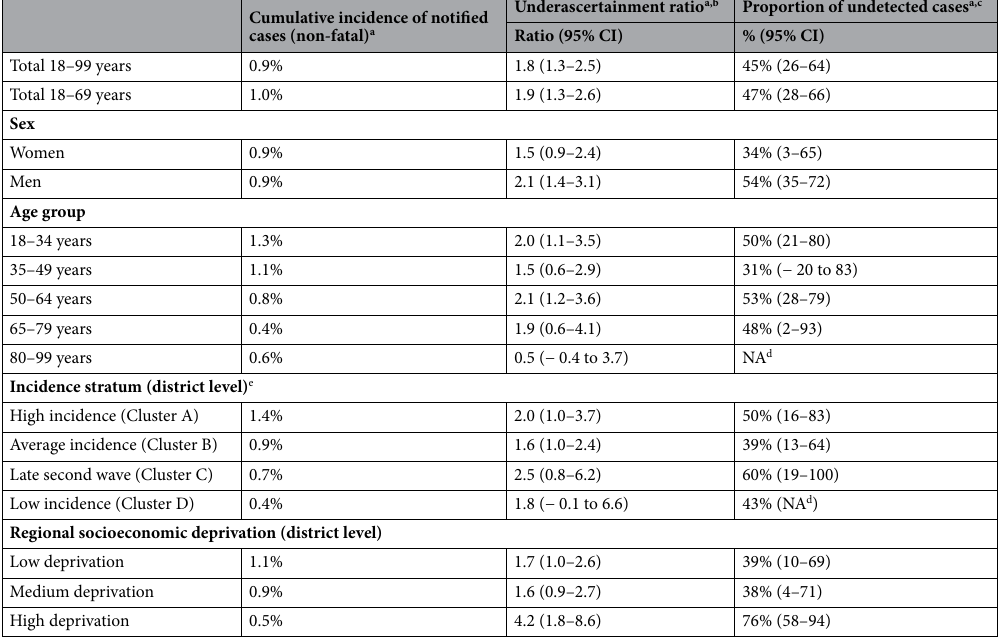
Table 3. Cumulative incidence of notified cases, underascertainment ratio and estimated proportion of undetected cases. a Cumulative incidence of notified cases in Germany, adjusted for sampling-density (i.e. each participant contributes according to the sex-, age group- and district-specific cumulative incidence of notified cases with symptom onset (notified or imputed) corresponding to his/her DBS testing date minus 14 days). b Underascertainment ratio: Ratio of seroprevalence to cumulative incidence of notified cases. Seroprevalence population-weighted IgG seroprevalence corrected for specificity = 0.997 and sensitivity = 0.616 that includes antibody decay observed in the study. c Proportion of undetected cases: seroprevalence minus cumulative incidence of notified cases, divided by seroprevalence. d NA = estimate not available. e District incidence strata according to pattern of weekly sequence of district SARS-CoV-2 incidence (notified cases), see Supplement